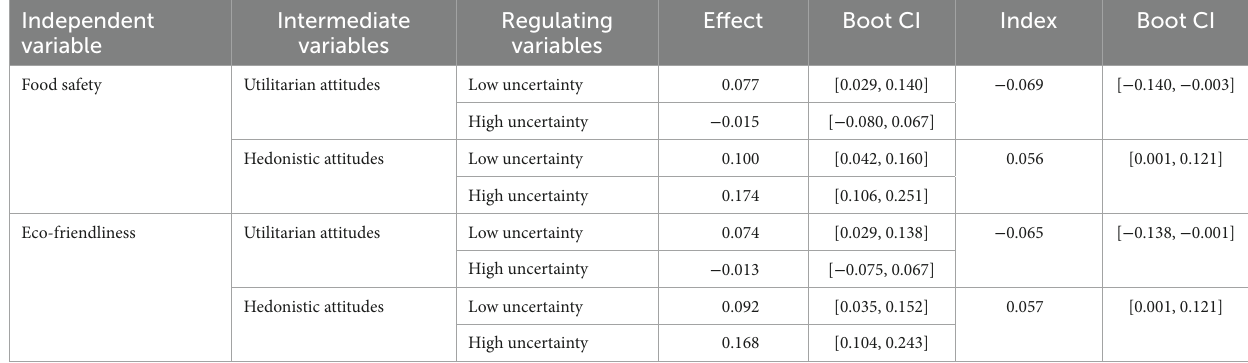
TABLE 8 Mediating effects with